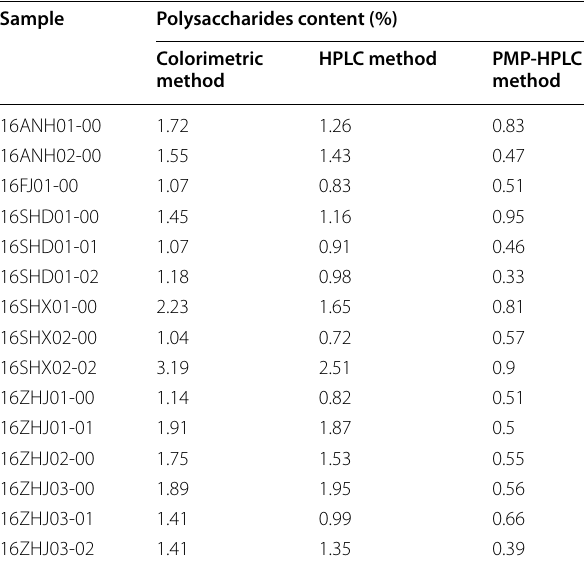
Table 3 The results of polysaccharides content by colorimetric, HPLC and PMP‑HPLC method